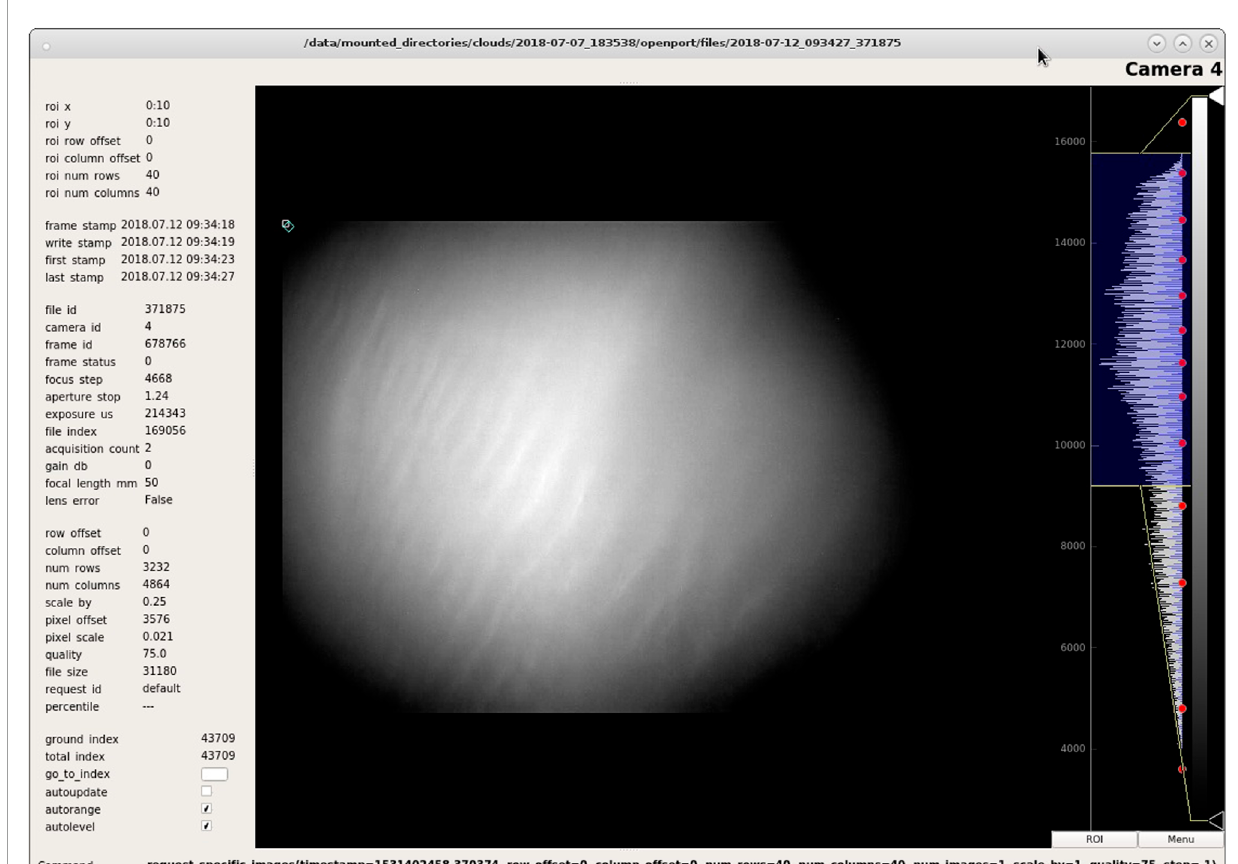
FIGURE 2 The pmc_viewer software during the 2018 PMC-Turbo flight. The diagonal striations in the image are Kelvin-Helmholtz Instabilities traced by PMCs. Figure originally published in Kjellstrand et al. (2020).